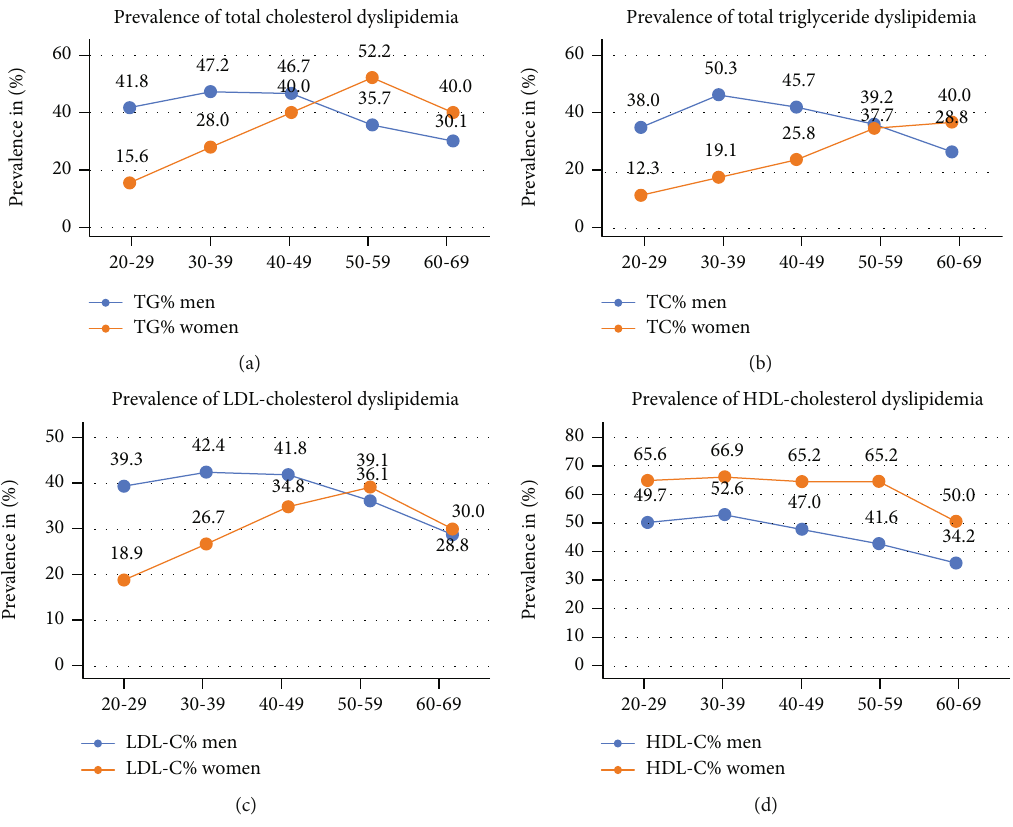
Figure 3: Age group-speci fi c trend of prevalence of dyslipidemia among Indian expatriate men and women. (a – d) Comparison of prevalence of dyslipidemia for various lipids in di ff erent age groups among men and women. Prevalence of dyslipidemia for total cholesterol, triglycerides, and LDL-C cholesterol is higher in men at younger age groups than women, p value < 0.0001. The mean TC, TG, and LDL- C in women showed a modest rise and supersede the levels in men at 50-59 years age group. After 60 years, the mean levels are decreasing in both genders except TG. The prevalence of HDL-C dyslipidemia is higher in women at all age groups, and a declining trend is noted in both genders ( p value <